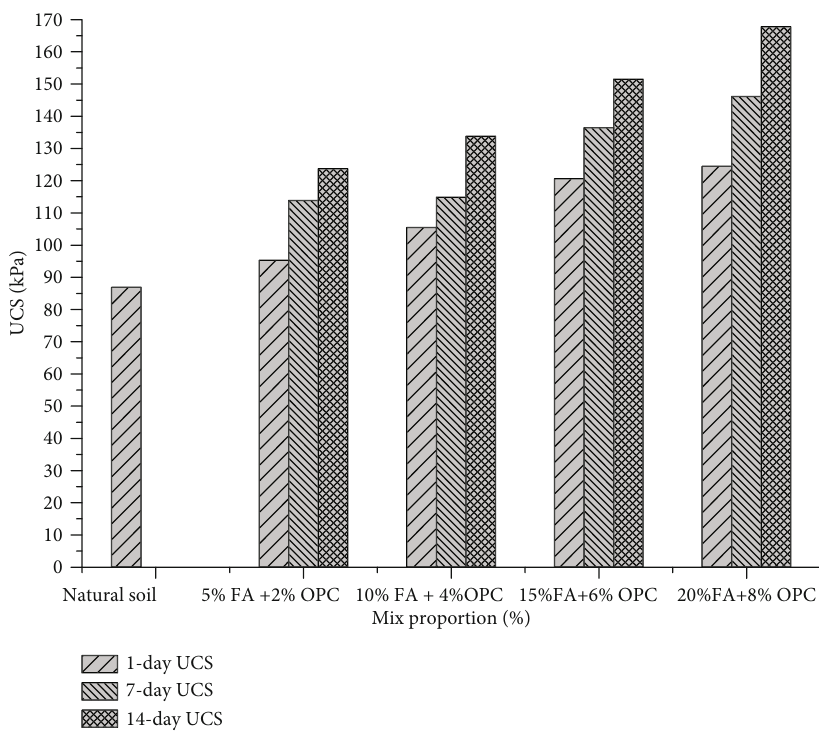
Figure 7: Comparison of uncon fi ned compression strength for soil sample with, and without, fl y ash and cement mixture.